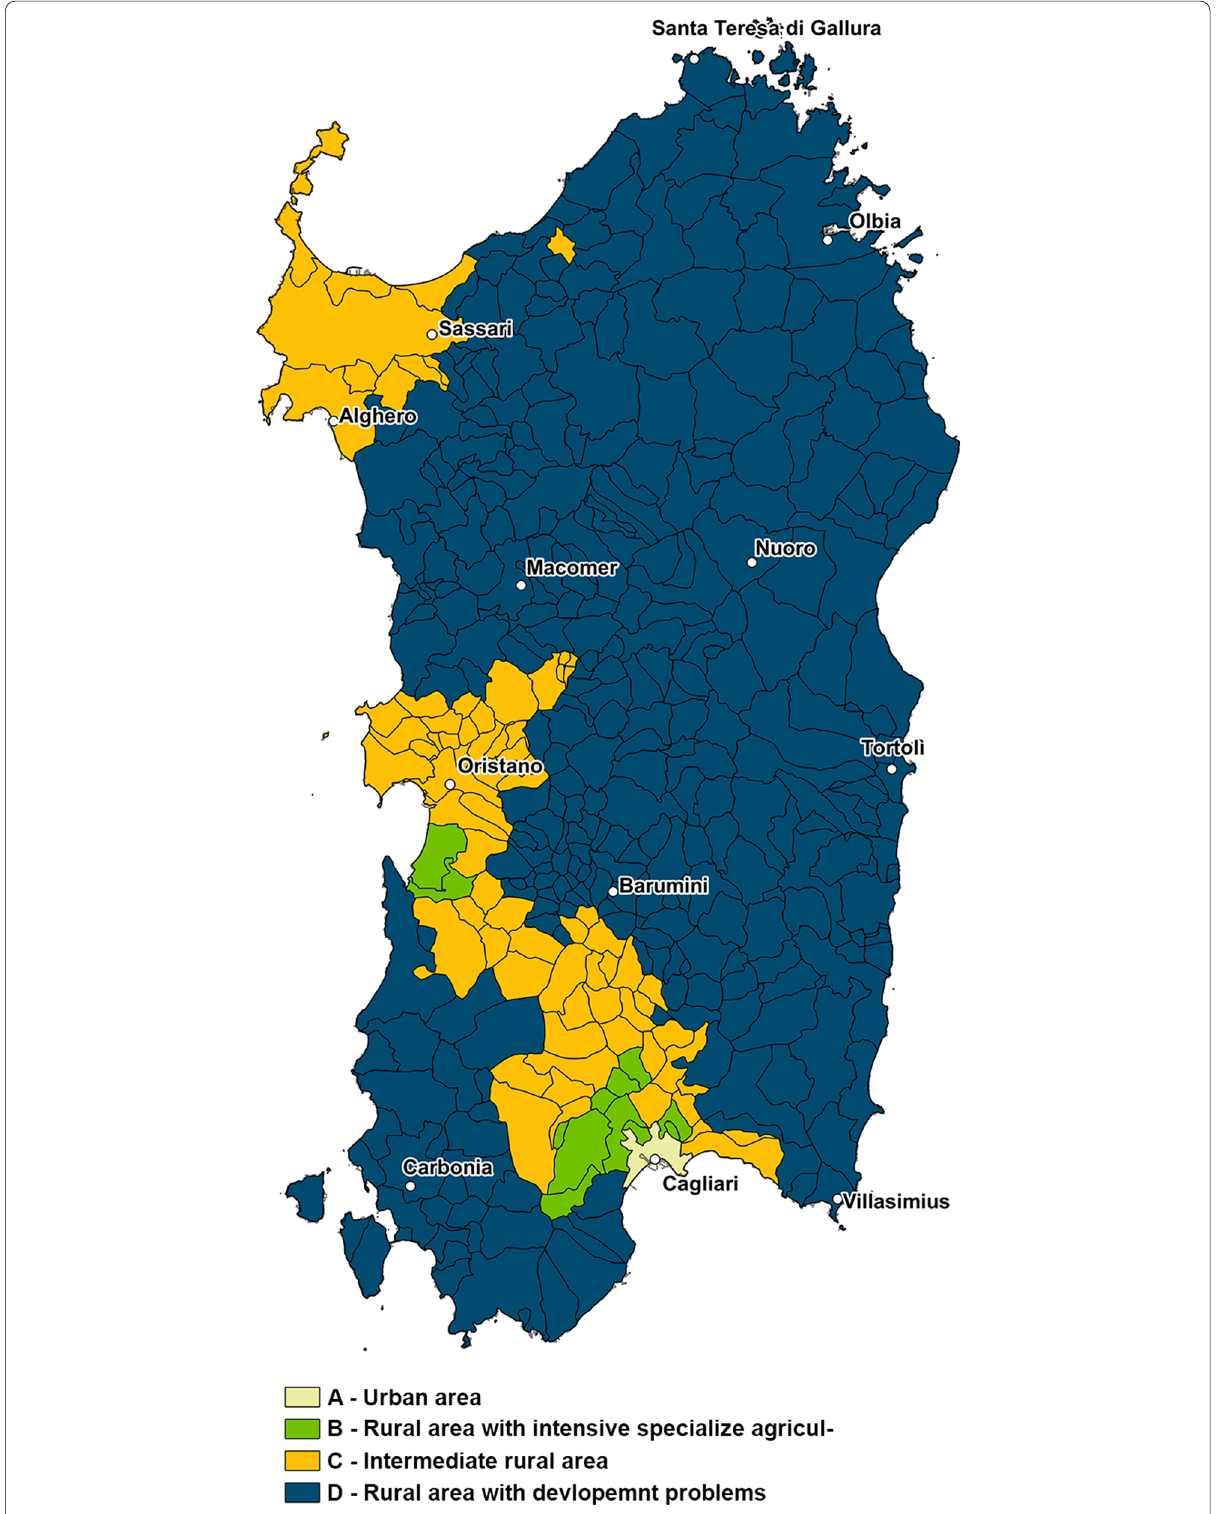
Fig. 1 Types of municipalities according to the OECD